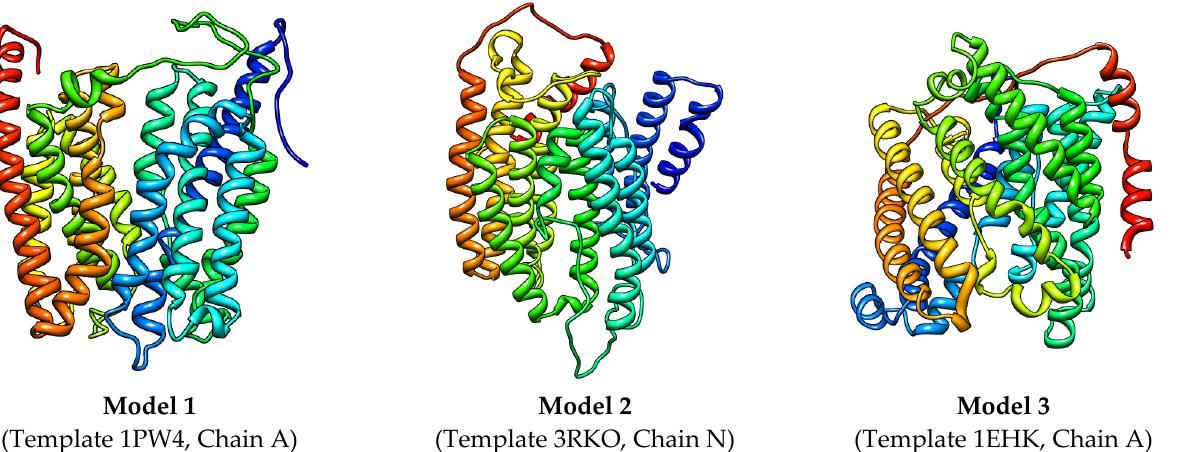
Table 2. Quality assessment of top homology models.